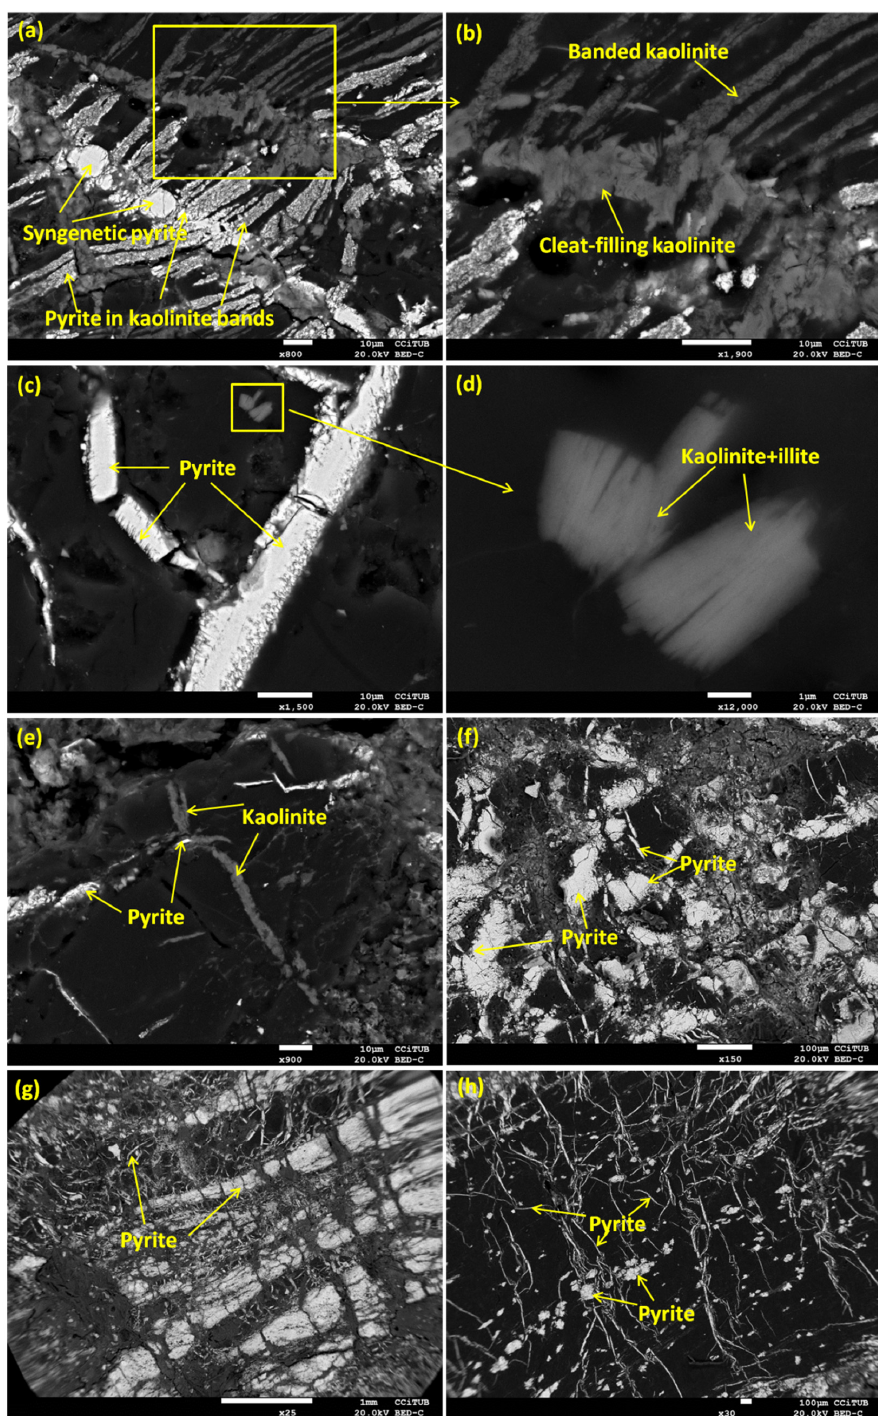
Figure 12. SEMback-scattered electron images of kaolinite, pyrite, and illite in the Jinhuashancoals (sample JHS-2). ( a ) Kaolinite and pyrite as cleat infillings as well as framboidal pyrite and banded kaolinite, in some cases remineralized by disseminated pyrite; ( b ) Enlargement of yellow square in ( a ); ( c ) Pyrite veins as cleat infillings and dispersed particle of kaolinite and illite; ( d ) Enlargement of yellow square in ( c ); ( e ) Banded kaoliniteand intergrown pyrite as cleat infillings; ( f , g ) Fragments of banded pyrite and pyrite mineralization in very fine to large cleats, mostly in vitrinite bands; ( h ) Discreted (mostly framboidal) pyrite crystals and massive pyrite as fine cleat